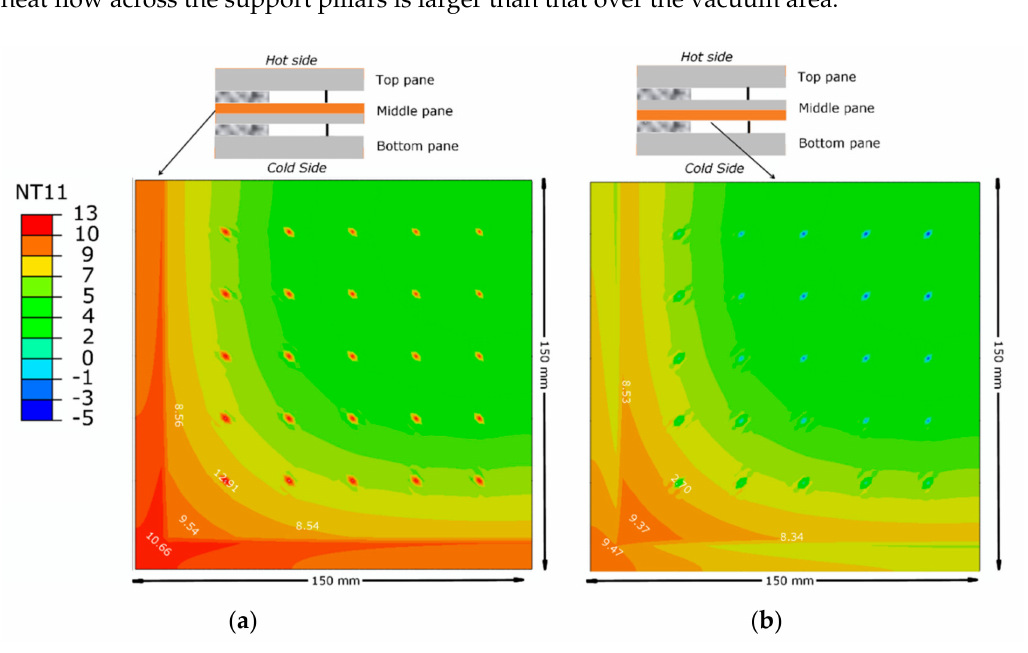
Figure 4. Isothermal temperature distribution on the middle-glass surface facing ( a ) the warm side and ( b ) cold side of the TVG, showing the temperature disparities in ◦ C from the 10-mm wide edge-sealed area towards the centre-of-pane